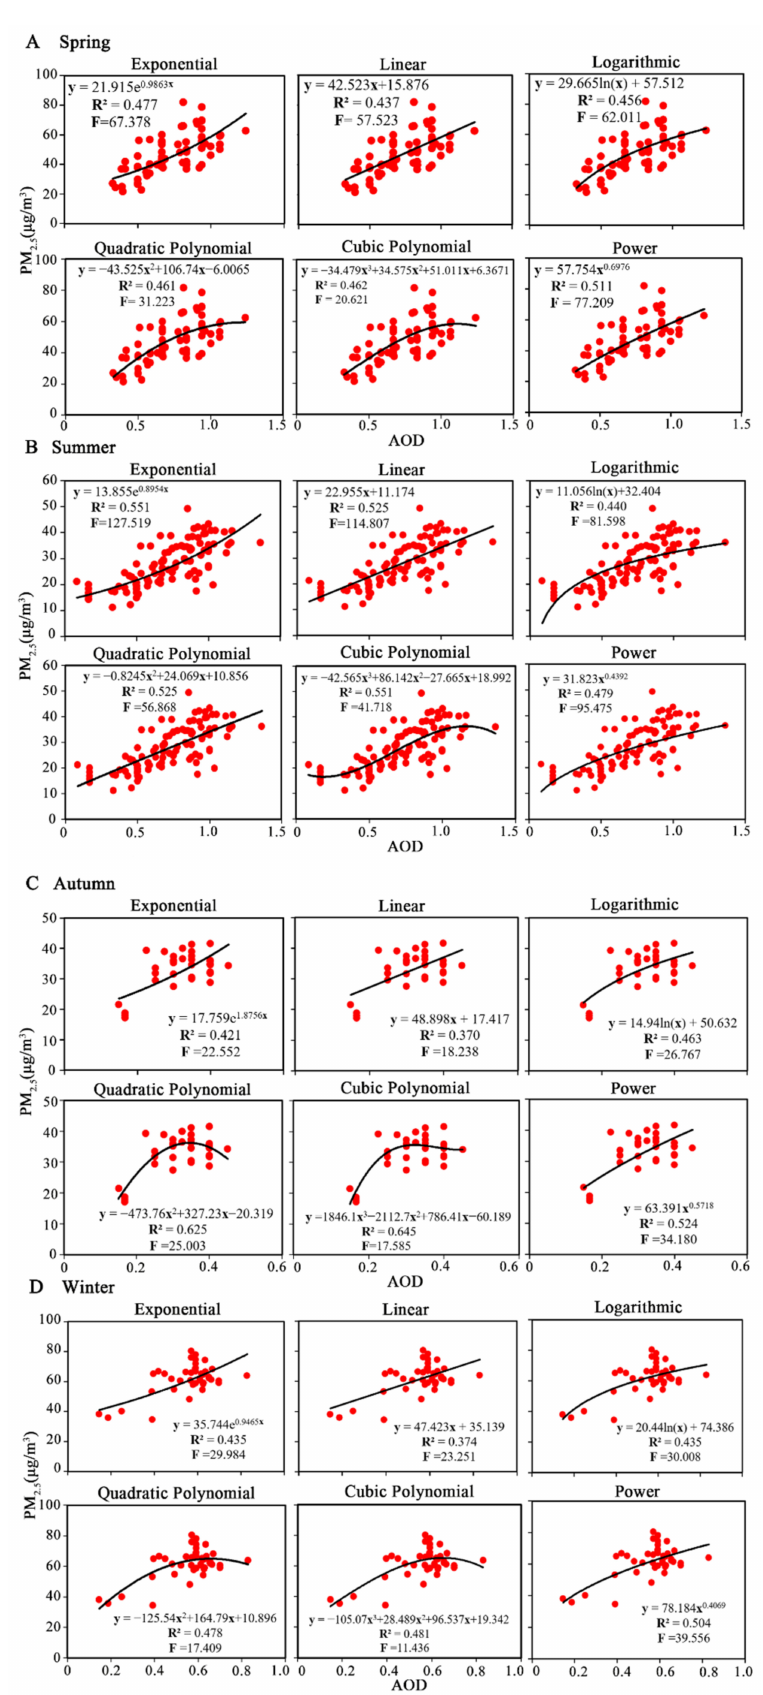
Figure 7. Seasonal model-building results. ( A – D ) for spring, summer, autumn, winter,